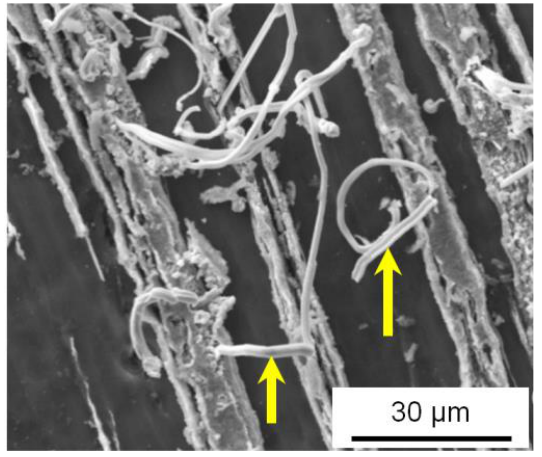
Figure 7. SEM (SE) image of the cross-section surface of Al-30Sn alloy subjected to three passes by ECAP-A . Sn extruded by internal stresses is shown by arrows.